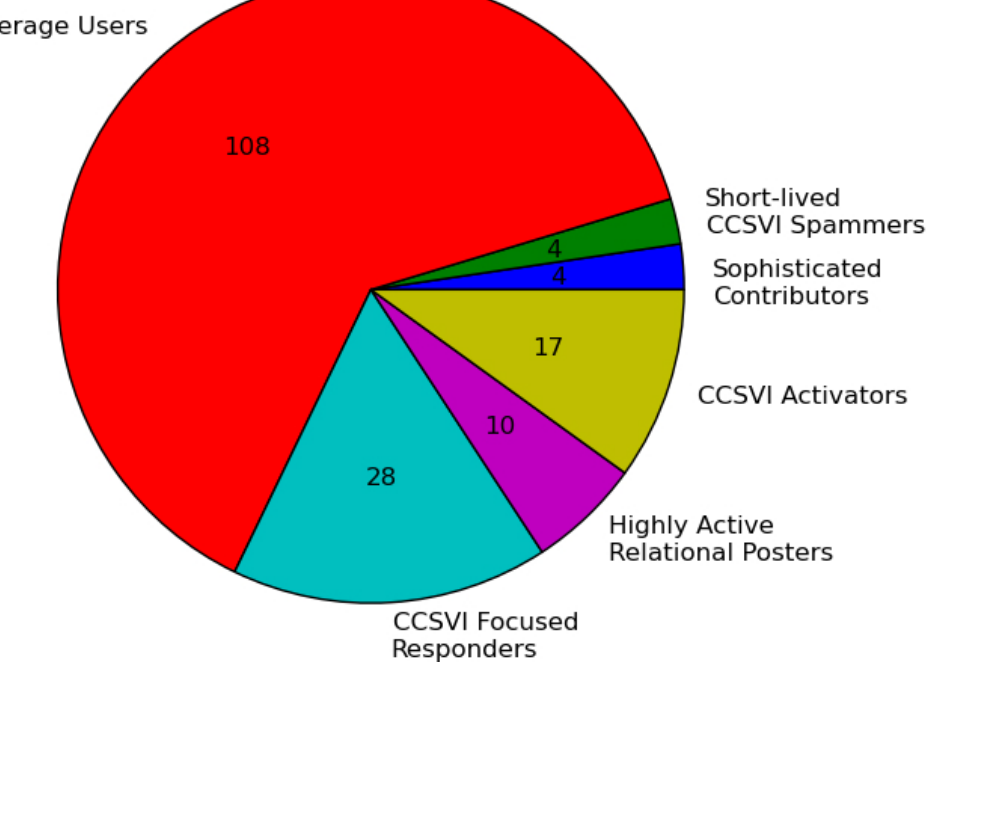
Figure 7. Posting behavior, according to the second clustering, with number of users in each cluster (n=171 included